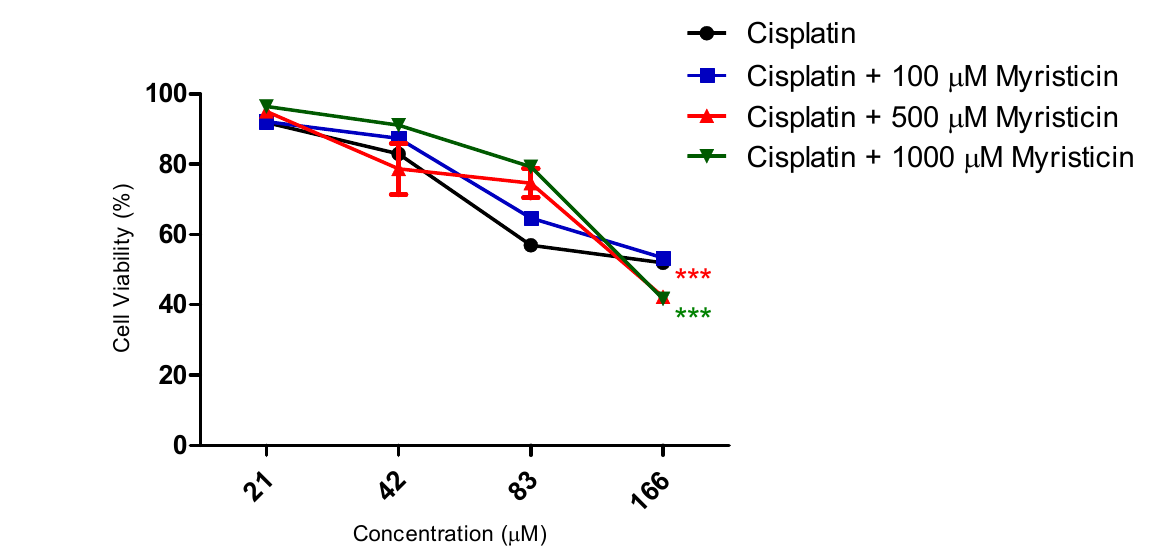
Figure 3. Cytotoxic activity of the compound myristicin in association with the chemotherapy drug cisplatin. Assay performed with the NCI/ADR-RES tumor line, relating the percentage of cell viability versus concentration of cisplatin, after 48 h of incubation.